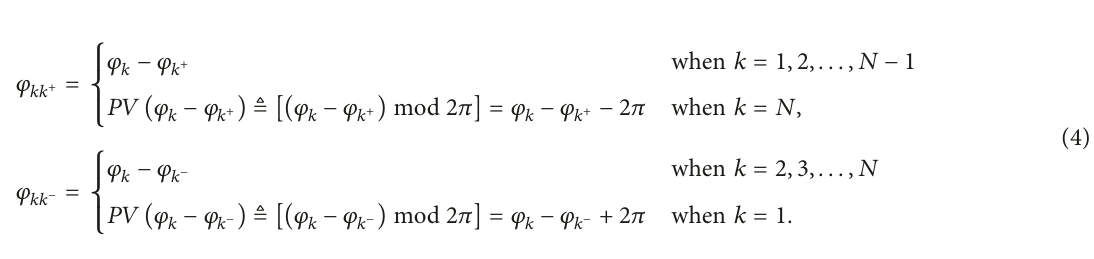
− 𝜑 {𝜑 { 𝑘 𝑘 + when 𝜑 = { 𝑘𝑘 +